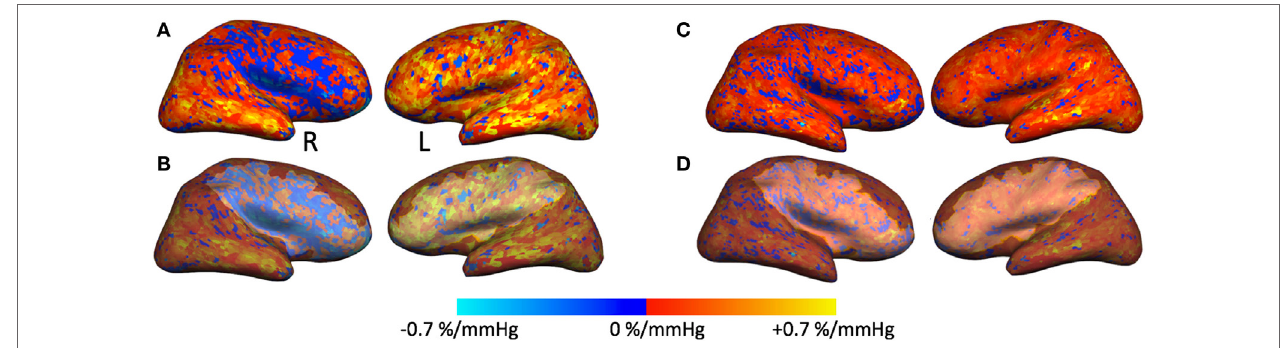
FIguRe 2 | Cerebrovascular reactivity (CVR) maps and regions of interest overlaid on cortical surfaces. (a,C) Right and left CVR maps overlaid on inflated cortical surface from the February 2008 time point (a) and December 2016 time point (C) . (B) The same CVR maps as in panel (a) that also include the region of interest (ROI) traced around the blue region of steal physiology in the right hemisphere and around the same region with normal CVR in the left hemisphere. These ROI masks were applied to subsequent time points for cortical thickness measurements as exemplified in panel (D) . FIguRe 3 | (a) Cerebrovascular reactivity maps overlaid on anatomical 3D T1-weighted acquisitions for registration to MNI space for displaying matching coordinates for region analysis. (B) 3D time-of-flight magnetic resonance angiography (MRA) of the circle of Willis that were re-registered to one another and slice corrected to include only the identical slices within the brain slab for each acquisition. Blue arrows denote the new collateralized vessels compared with previous scans.